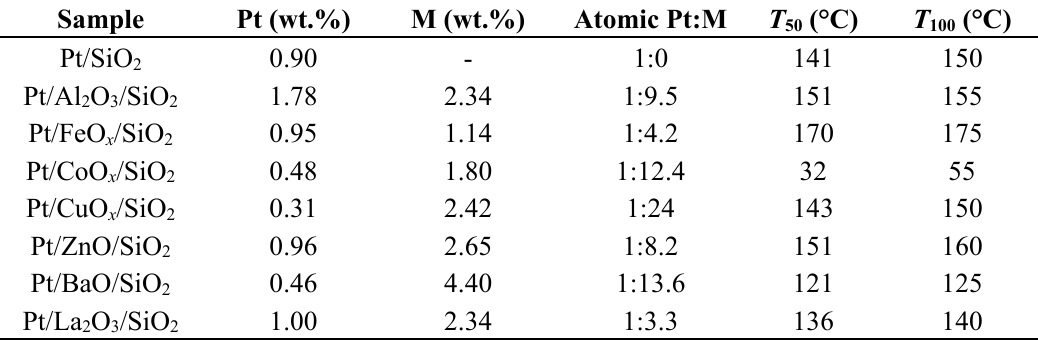
Table 1. ICP results, T 50 , and T 100 for Pt/MO x /SiO 2